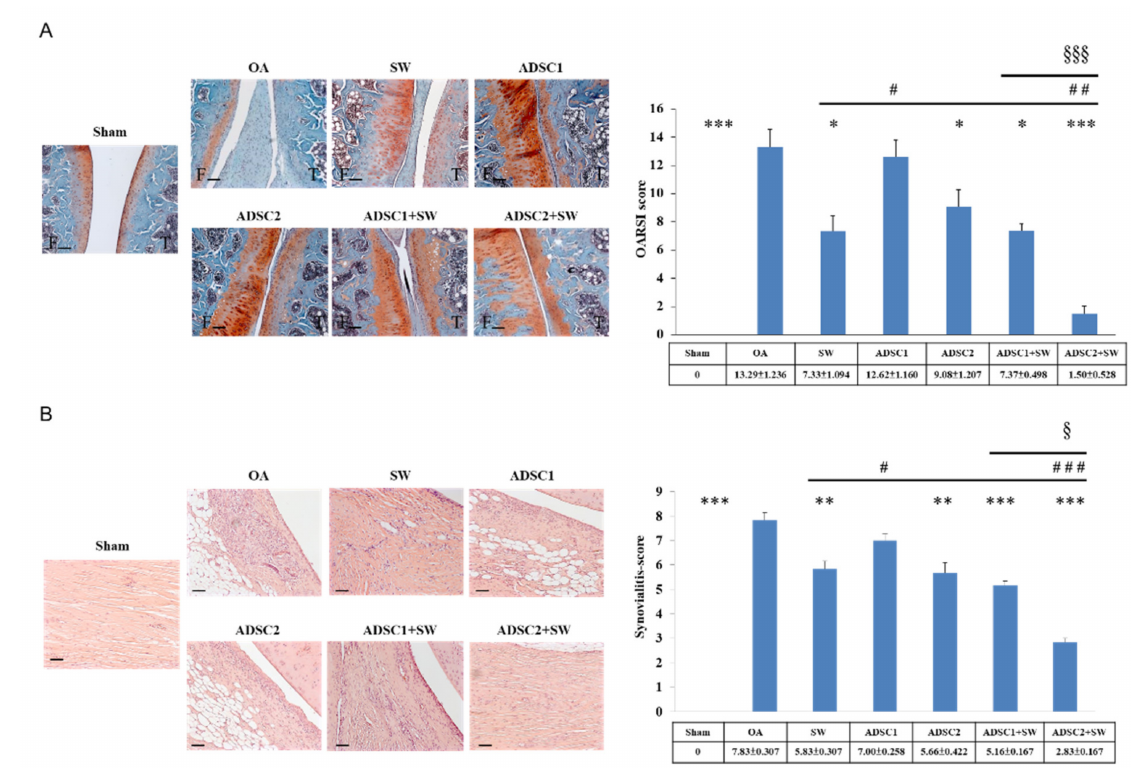
Figure 3. The histological changes of the articular cartilage and synovium membrane in knee OA after treatment. ( A ) Dam- age to and recovery of the articular cartilage in each group as measured by safarine-O staining and the OARSI score. The images were at 100 × magnification. The scale bar was 100 µ m. ( B ) The inflammatory synovial membrane observed by hematoxylin-eosin staining at 200 × magnification. The scale bar was 50 µ m. The synovitis score was calculated for each group. * p < 0.05, ** p < 0.01, and *** p < 0.001 as compared with the OA group. # p < 0.05, ## p < 0.01, and ### p < 0.001 as compared with the SW group. § p < 0.05 and §§§ p < 0.001 as compared with the ADSC1 + SW and ADSC2 + SW groups. n = 6 rats in each